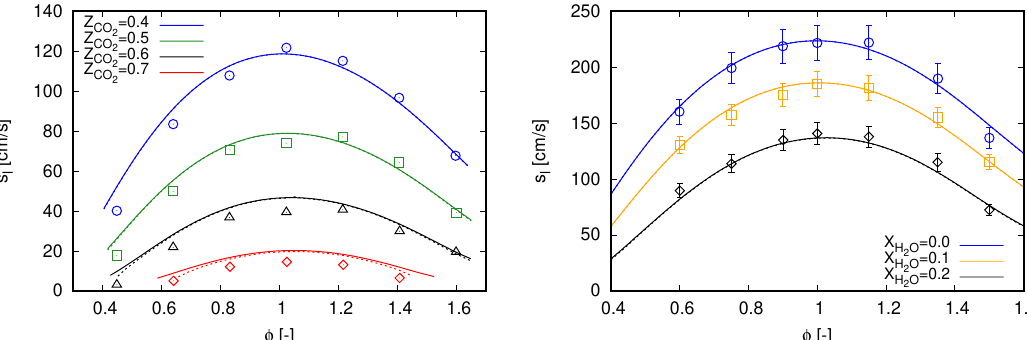
Figure 1. Laminar flame speed computed with GRI 3.0 using freely propagating flame reactors. Marks, experimental data; continuous lines, adiabatic simulations; dashed lines, simulations with radiation heat losses. ( left ) CO 2 dilution with experimental data extracted from [3]; and ( right ) H 2 O dilution with experimental data extracted from